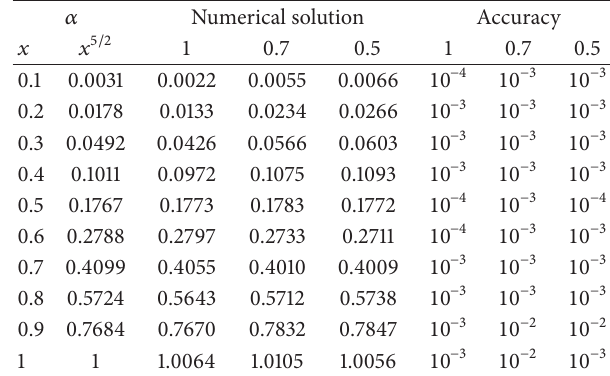
Table 3: Exact solution, approximate solution, and accuracy for Example 2 .